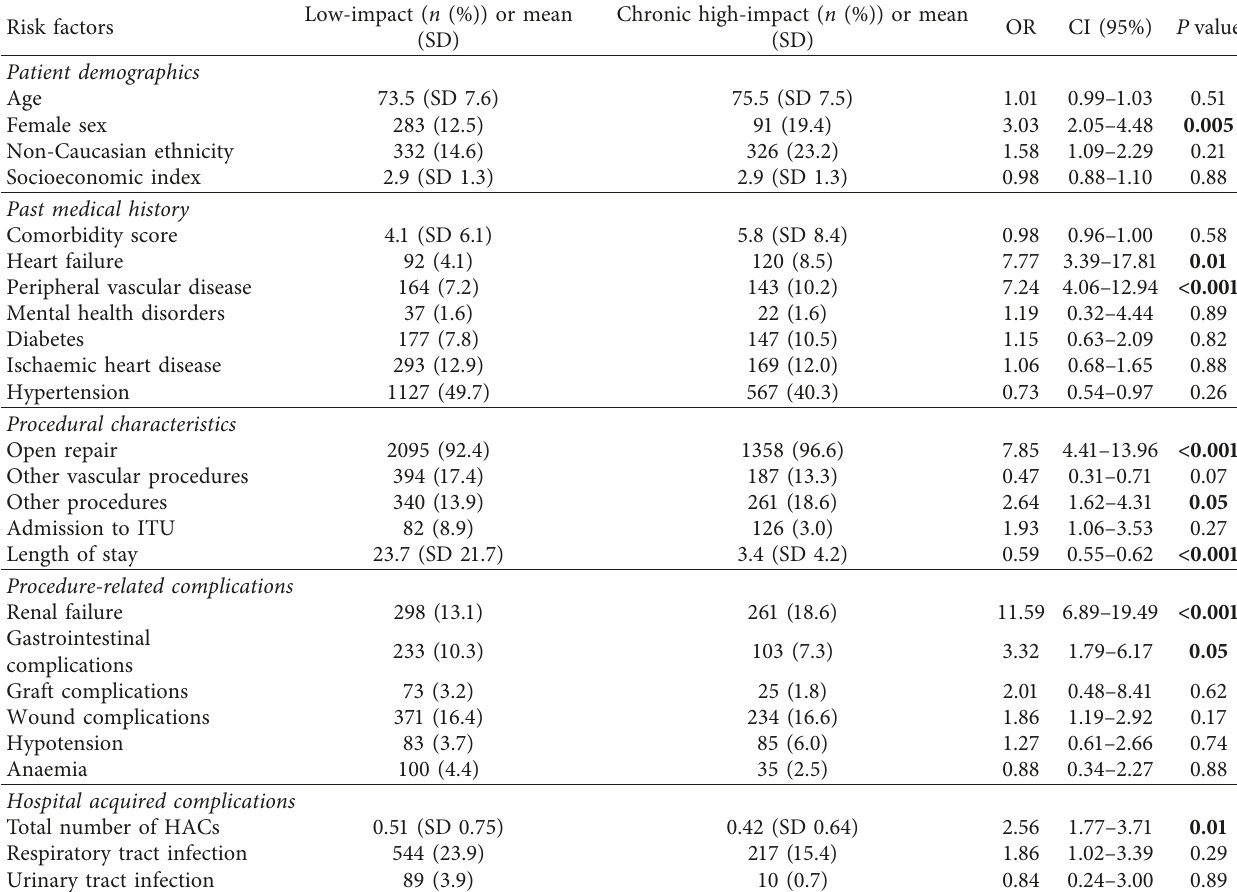
Table 2: Covariates associated with Group 1 (chronic high-impact) as compared to low-impact users among patients who had rAAA repair. Risk